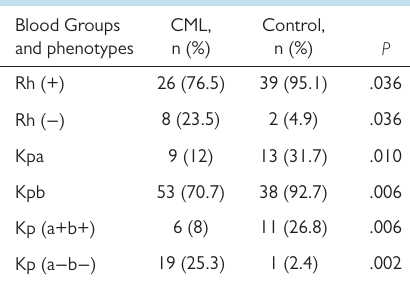
Table 6. Significant Differences Between CML And Control Groups in Terms of ABO, Rh, Kell, Duffy, C, c, E, e Blood Groups and Duffy, Kell, Rh Blood Group